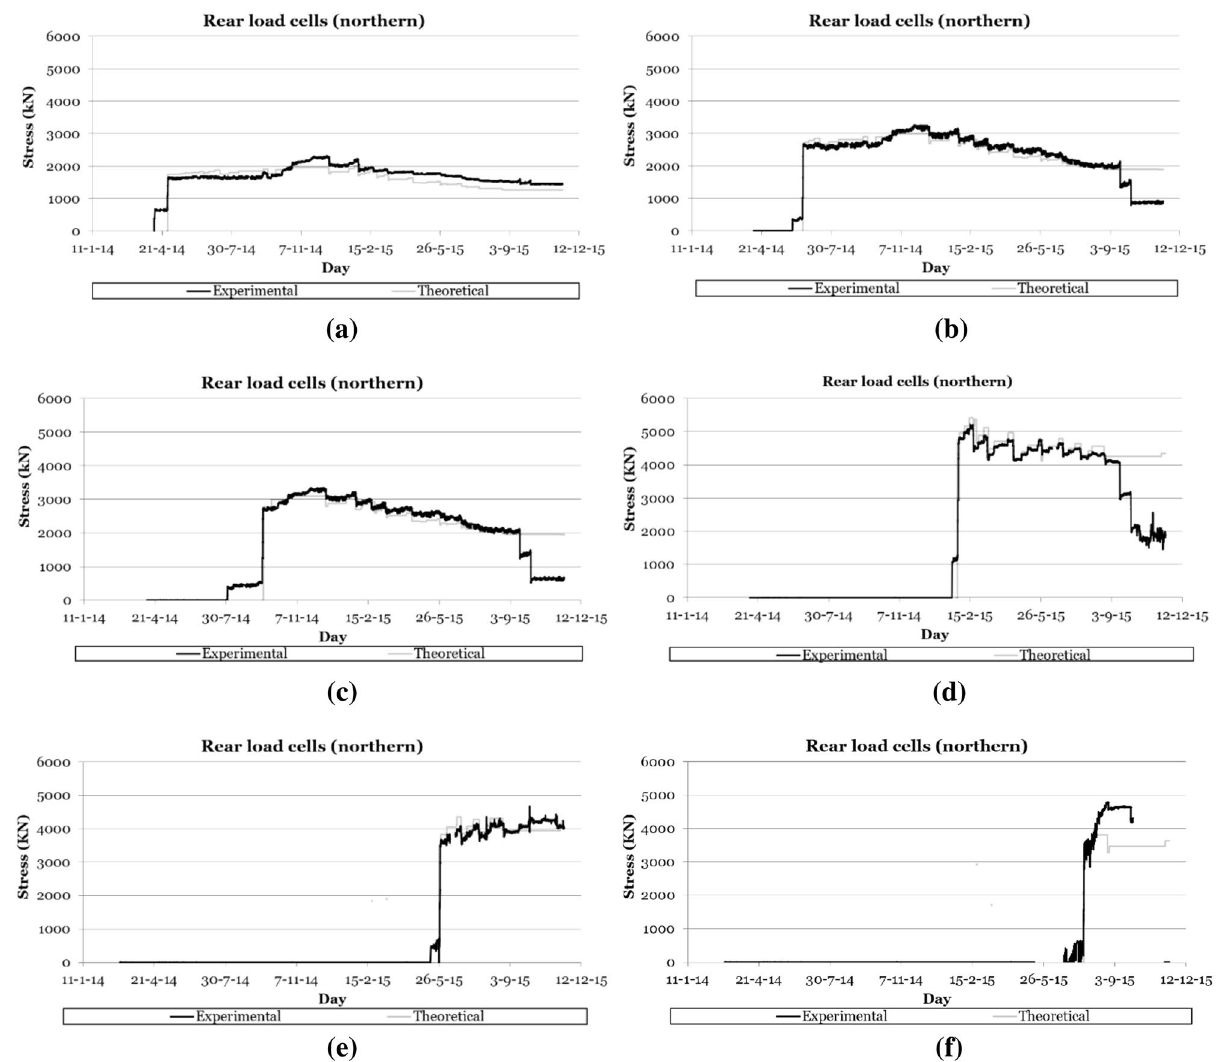
Figure 3. Recording the evolution of stresses in the retaining cables of the northern semi-arch: ( a ) 2nd cables family; ( b ) 4th cables family; ( c ) 6th cables family; ( d ) 8th cables family; ( e ) 12th cables family; ( f ) 14th cables